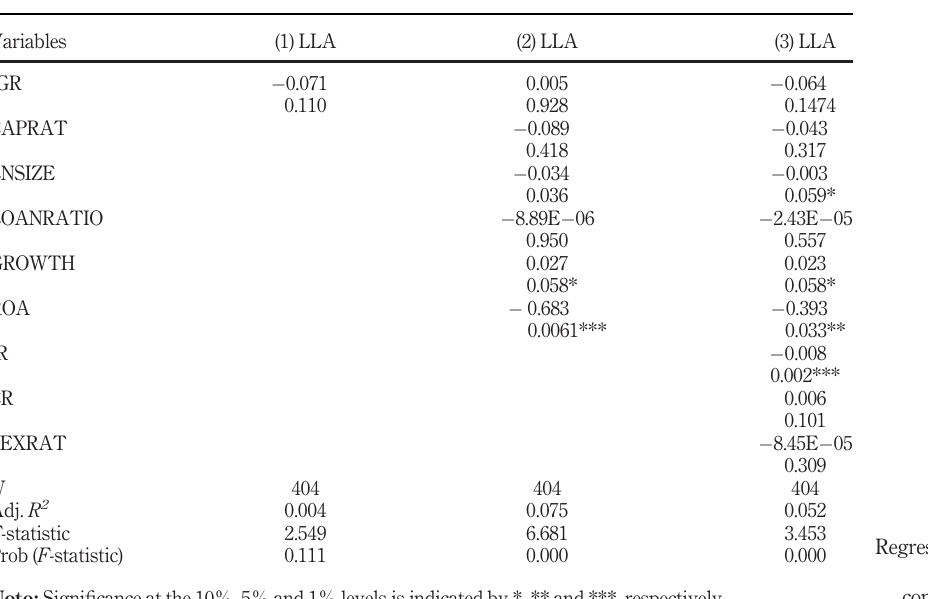
Table 8. Regression result for